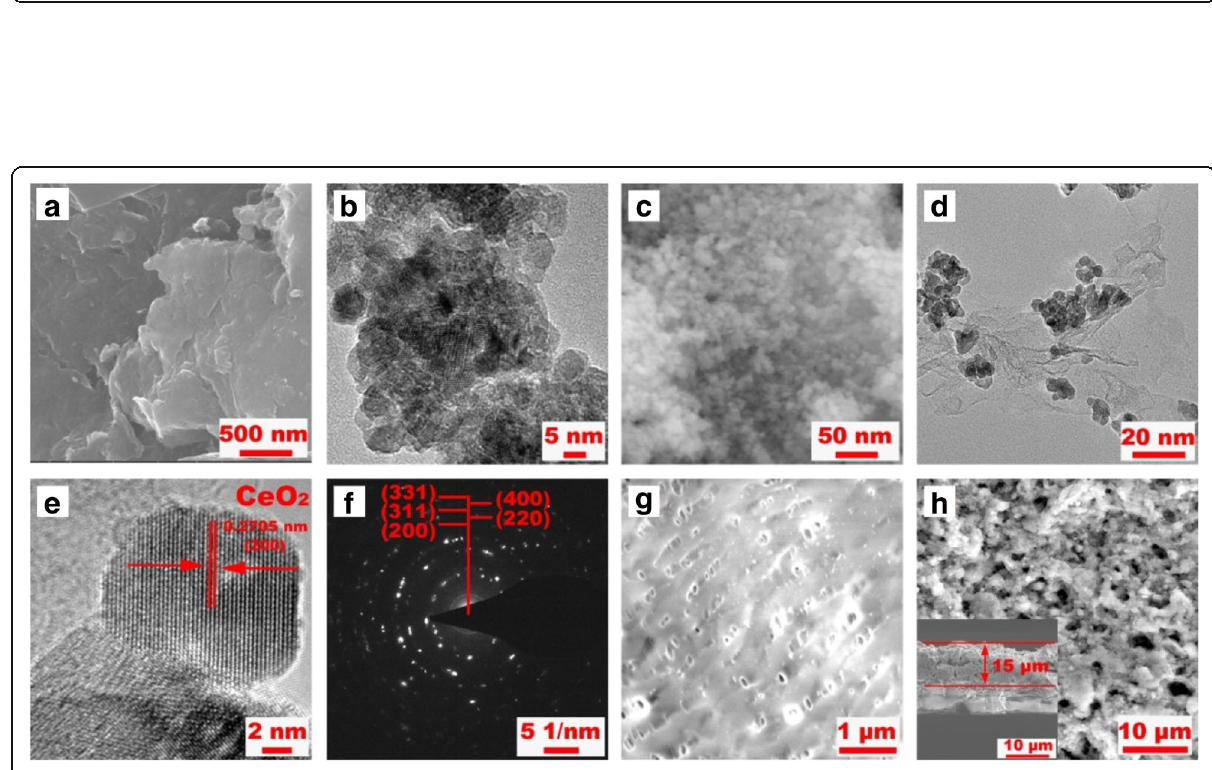
Fig. 2 XRD patterns of the samples ( a ). Raman spectra of CeO 2 /RGO composite and RGO ( b ). N 2 adsorption-desorption isotherm of CeO 2 /RGO composite ( c ). Pore size distribution of CeO 2 /RGO composite ( d